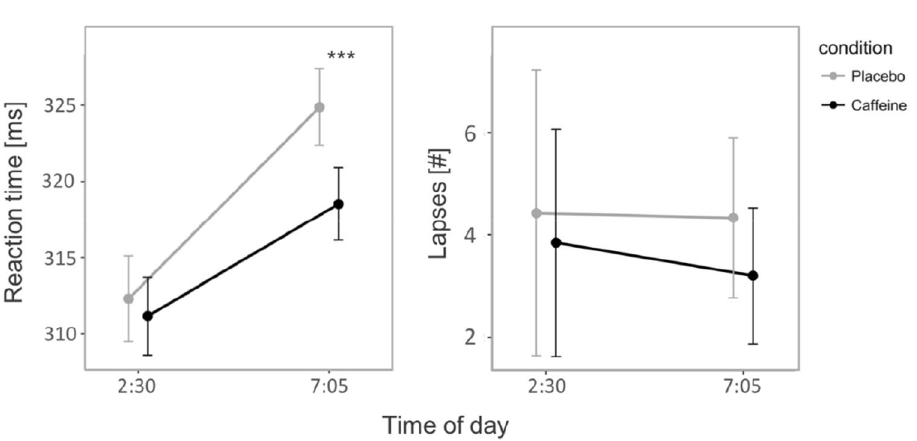
Figure 3. Median PVT reaction time (left) and number of lapses (right) at 2:30 and 7:05. Mean values (dots) and standard error of the mean (vertical lines) are shown. Grey lines indicate the placebo condition; black lines indicate the caffeine condition. *** p < 0.001 (Benjamini–Hochberg